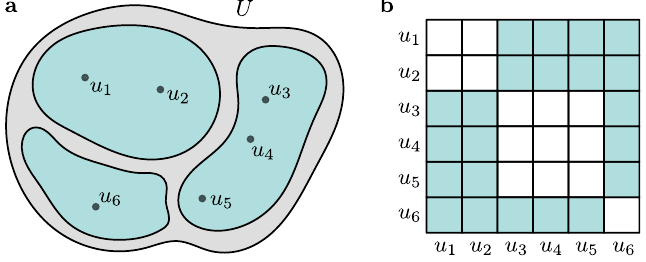
Figure 1. Pictorial representation of a set with a partition and its distinction. (a) A set U with six elements u i is divided in a partition p with three blocks (green areas). (b) The set U (cid:2) U has each of its points characterized by a square in a 2D mesh. Points that belong to dit( p ), i.e., pairs whose components belong to different blocks are colored in